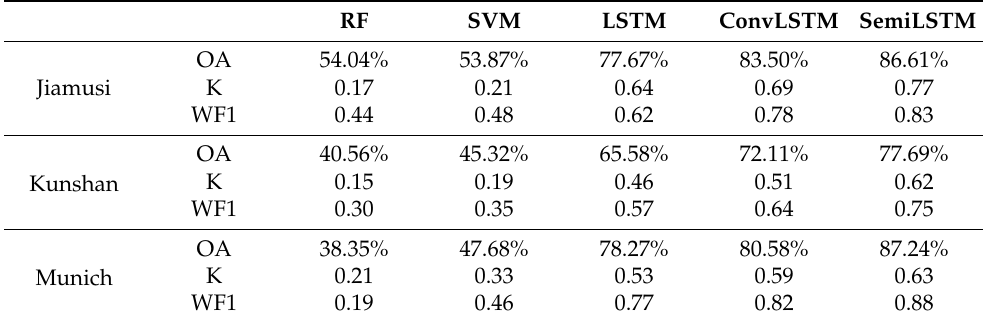
Table 1. Overall accuracy (OA), Kappa coefficients (K), and weighted F 1 score (WF1) tested on various data